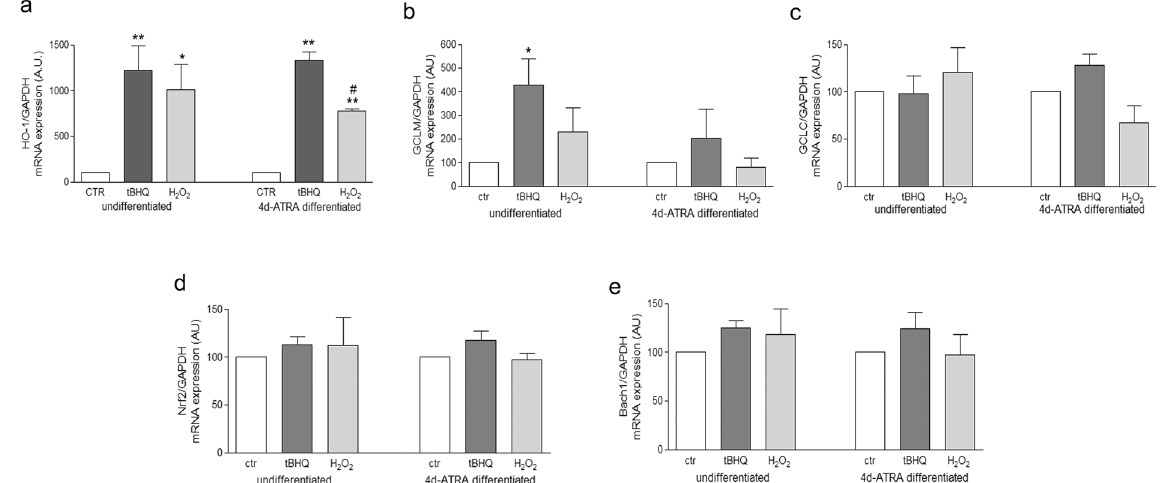
Figure 2. HO-1 mRNA expression is differently regulated in response to oxidative stress before and after cell differentiation. RT-PCR analysis of HO-1( a ), GCLM ( b ) and GCLC ( c ), Nrf2 ( d ) and Bach1 ( e ) in undifferentiated and 4d-ATRA differentiated cells treated for 6 h with 500 μ M H 2 O 2 or 50 µ M tBHQ - positive control of HO-1 induction - as indicated. Statistical analysis: n = 3 * p < 0.05 vs control; ** p < 0.01 vs control; # p < 0.01 vs